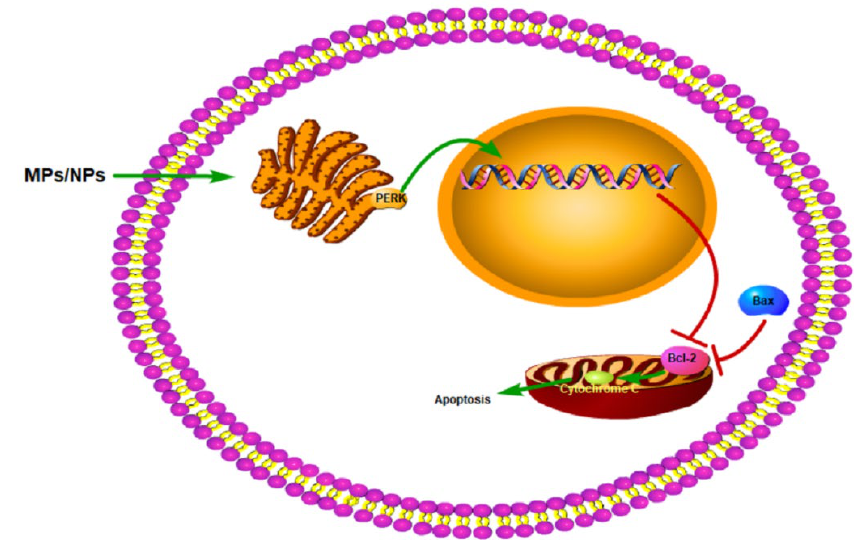
Figure 5. Schematic diagram of MPs/NPs-mediated hepatic apoptosis. Table 8. The study parameters of MPs and NPs in liver apoptosis.